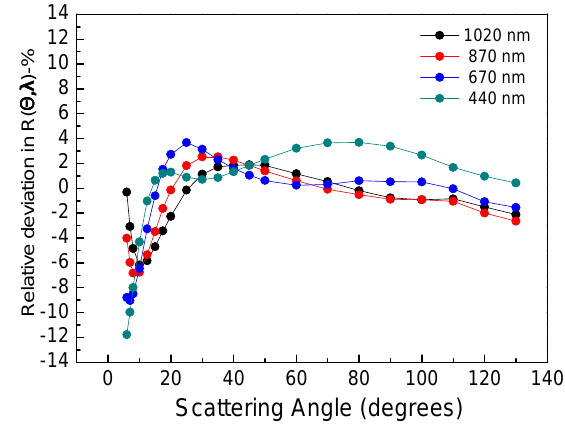
Fig. A2. Relative deviations between assumed and retrieved R( 2 , λ) for the analyzed case presented in Table